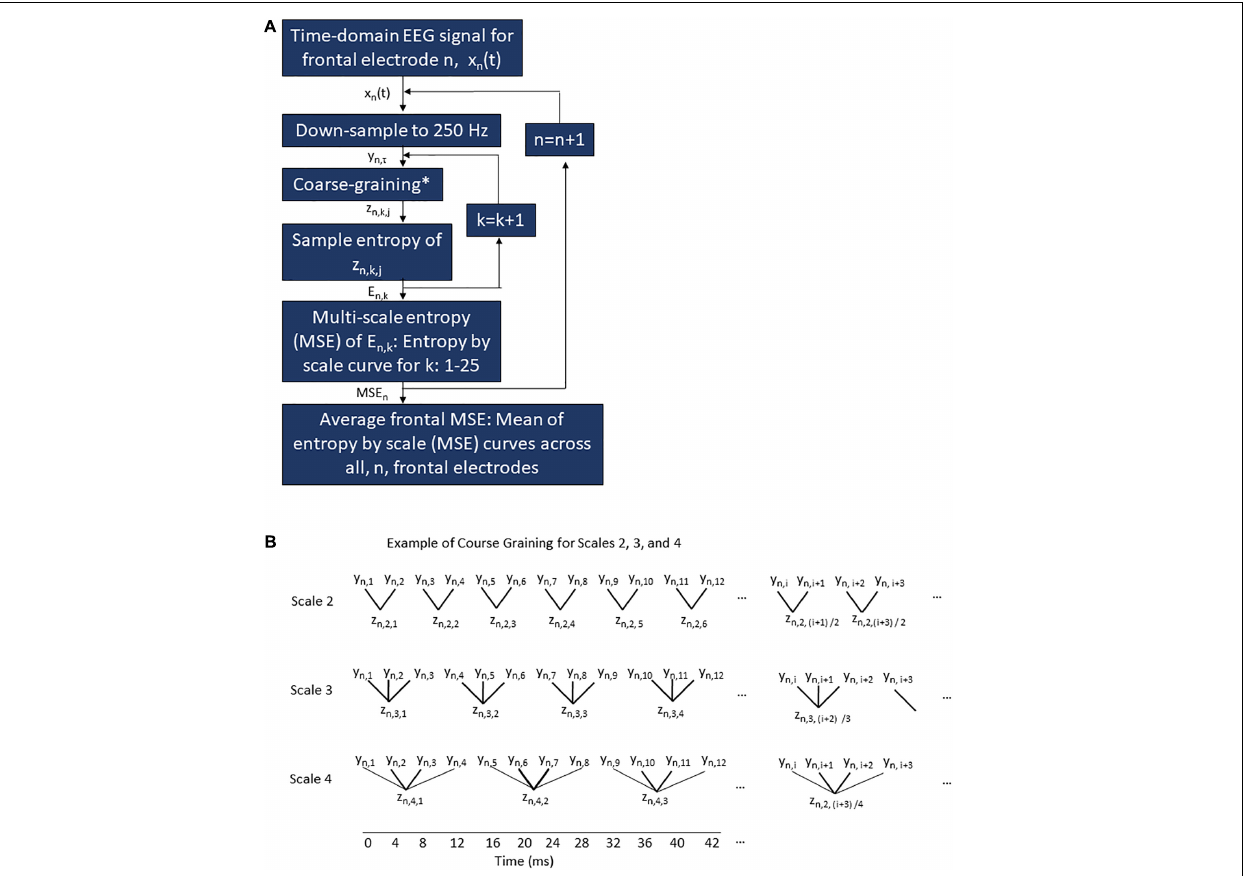
FIGURE 1 | Multi-scale entropy procedure for frontal EEG electrodes (A) and example of course graining (B) . (A) A flow chart of the processing algorithm applied to the raw EEG signal for a given condition (pre-operative or intra-operative) for a given subject to generate the frontal average MSE curve for a given condition/subject. The time domain signal recorded at 1,000 Hz from a given frontal electrode, n , is represented as x n ( t ) where t ranges from 0 to 3 min. This raw signal x n ( t ) is down-sampled to 250 Hz to generate the time series y n , τ where τ is the sample number from 1 to 45,000. Each sample encompasses 4 ms. The down-sampled time series y n , τ is then course-grained for a given scale k (as shown in the examples of scale k = 2, 3, and 4 in B ) to generate the coarse-grained signal z n , k , j , where z n , k = 1 , j at scale 1 is identical to y n , τ and where j ranges from 1 to ( τ + k –1)/ k . The sample entropy is then calculated for each z n , k , j signal to yield an entropy value E n , k . This is repeated for each scale k . Once E n , k has been calculated for all scales k = 1–25, an MSE curve for a given subject, condition, and electrode, n . The MSE n curve ranges on the x -axis from scale k = 1–25. The MSE n curve on the y -axis is E n , k . This is repeated for every electrode, n , in the frontal region. Finally, the MSE curves for all n electrodes are averaged across scale k to yield a single frontal MSE curve for each subject/condition. (B) Example of course graining procedure perform on the down-sampled time series for electrode n , y n , τ , where τ ranges from 1 to 4,500, to yield the course-grained series z n , k , j where n represents the electrode in question, k is the scale value, and j is the sample number. Scales 2, 3, and 4 are shown for examples above, but this same pattern continues up to scale 25. The temporal resolution associated with the course graining is show on the axis at the bottom of the